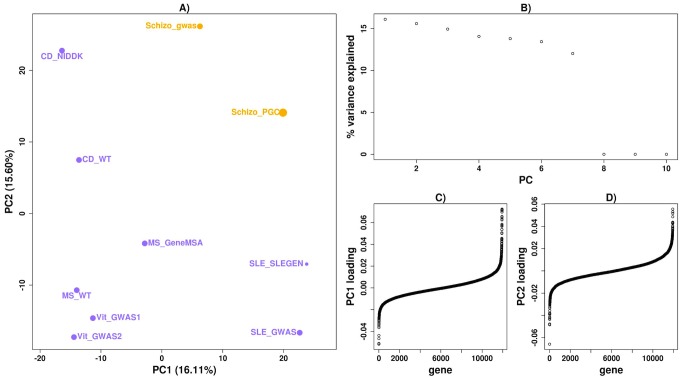

disPCA of datasets of the same disease.A) Pairs of datasets of the same autoimmune diseases and schizophrenia are displayed on PC1 and PC2. Dataset labels are indicated in the form of disease-type_ study-name. The size of points is proportional to the sample size of the original study (Table S2). Diseases include systemic lupus erythematosus (SLE), vitiligo (Vit), multiple sclerosis (MS), schizophrenia (Schizo) and Crohn's disease (CD). Datasets of the same diseases tend to lie closer together on PC1 and PC2. B) The portion of variance explained by each PC is displayed. C) The weightings for genes on PC1 are displayed and ordered according to their weights. D) Similar to (C) with loadings for PC2.